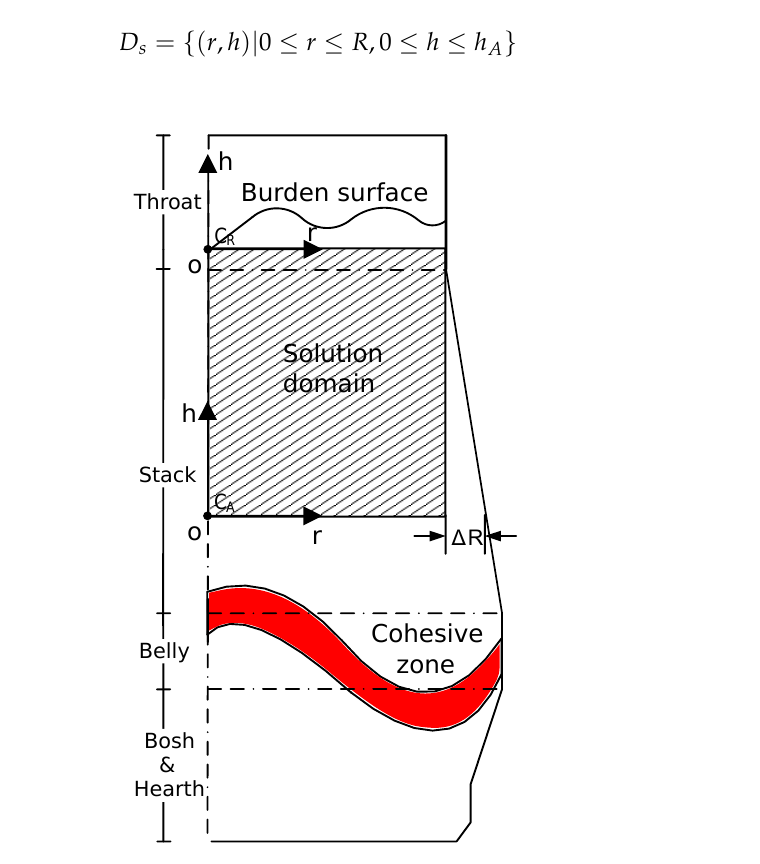
Figure 6. Solution domain of the descent speed along the burden